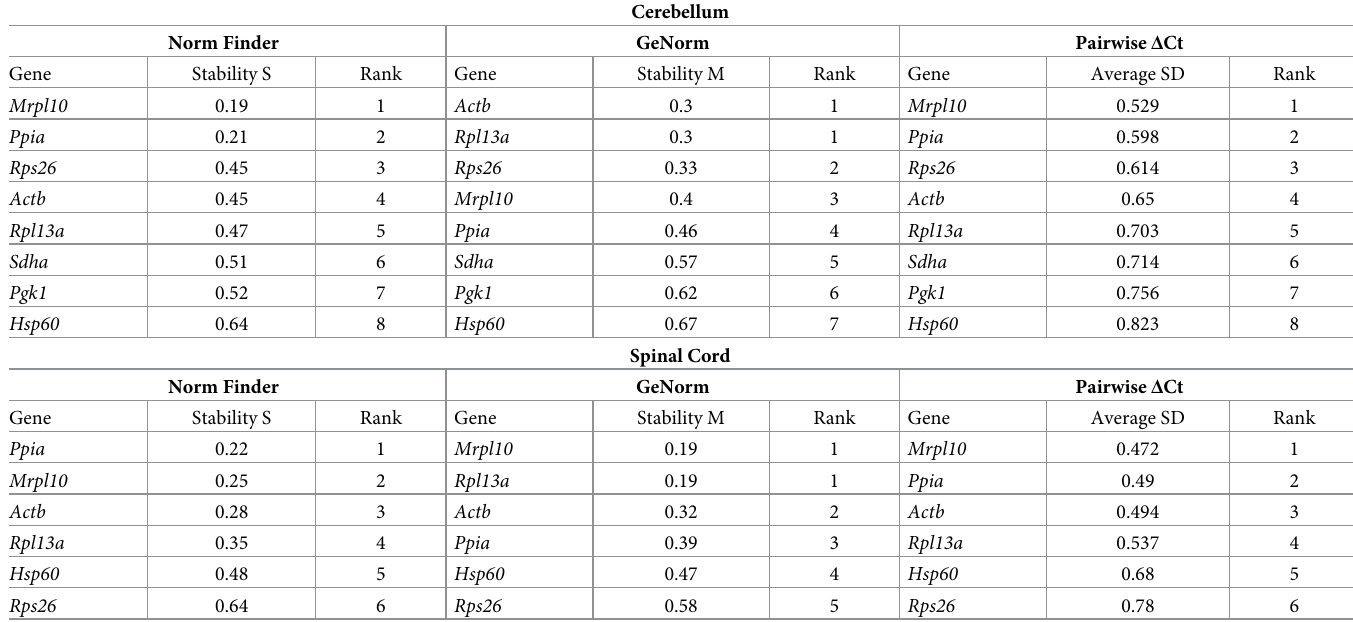
Table 2. Revised rankings of candidate reference genes in cerebellum and spinal cord using NormFinder, GeNorm and the Pairwise Δ Ct